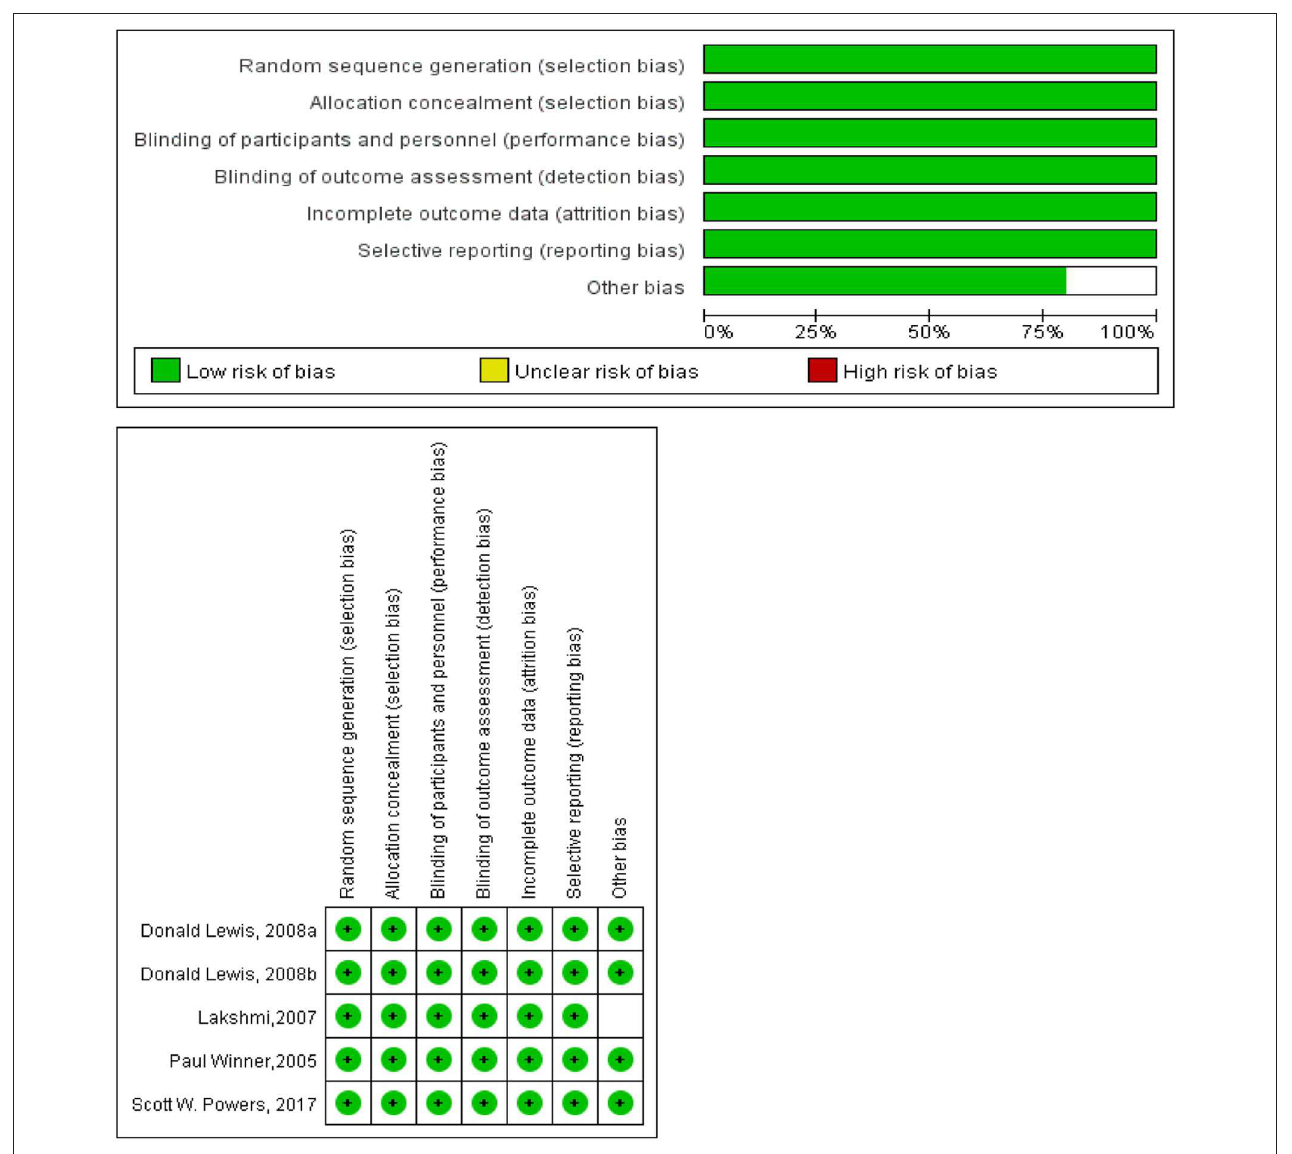
FIGURE 2 | Risk of bias graph and summary.